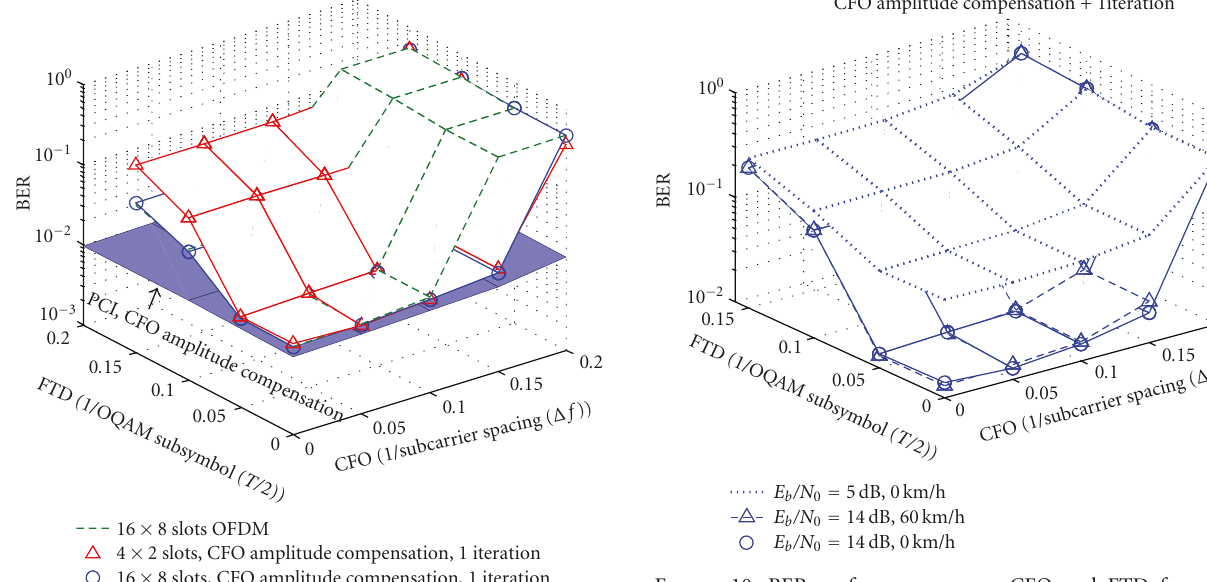
Figure 10: BER performance versus CFO and FTD for uplink transmission of 4 × 2 AMC23 slots in Vehicular-A channel at E b /N 0 = 5dB and E b /N 0 = 14 dB using 4-QAM. Static user and user with 60 km/h mobility. Synchronization with CFO amplitude distortion correction and one